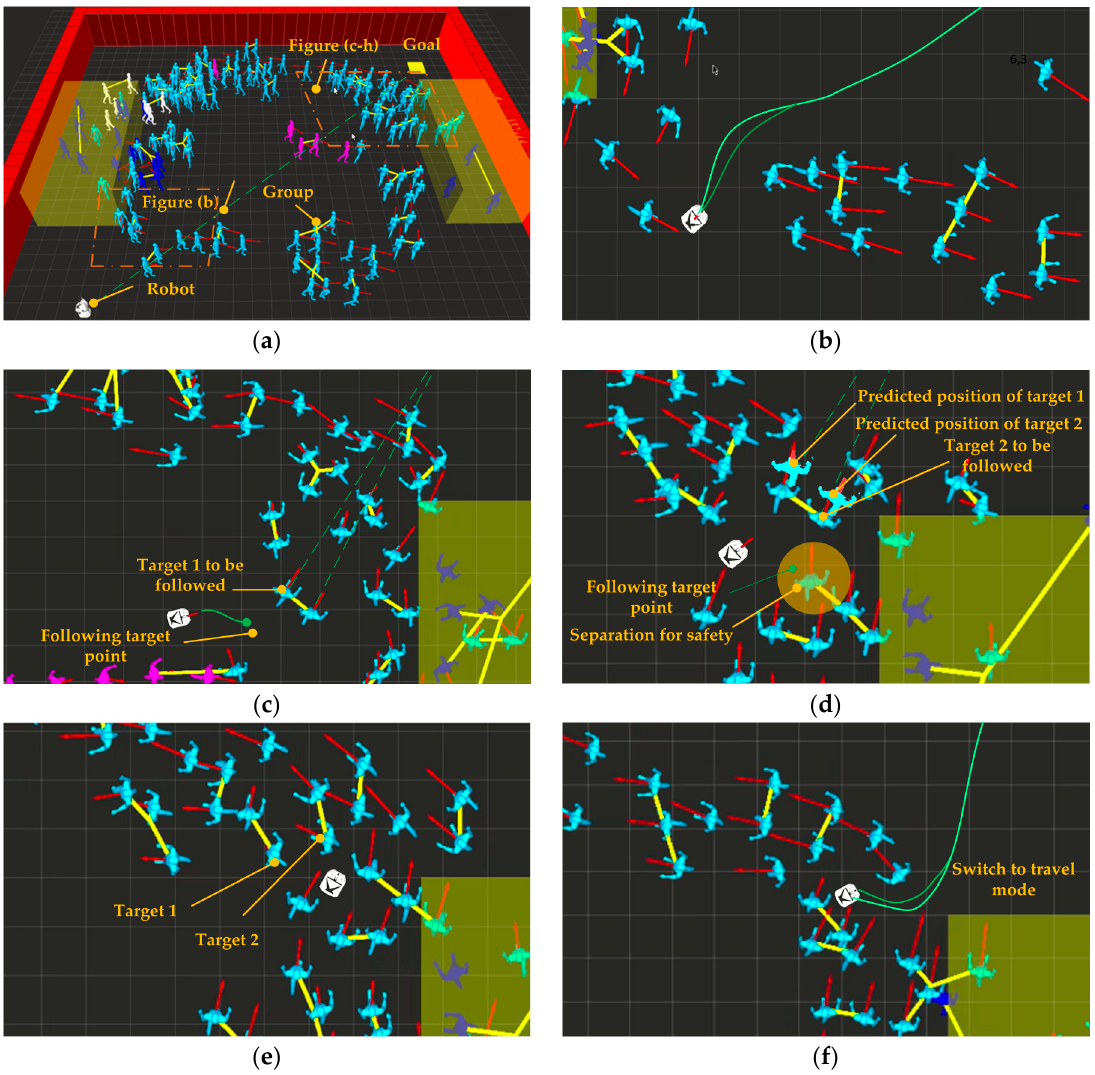
Figure 13. Experiment in a complex crowd simulation environment: ( a ) Overview of the scenario; ( b ) the robot passes through the crowd for the first time; ( c ) the robot chooses to follow the target 1; ( d ) the robot is detecting the accessibility of the candidate following target 2; ( e ) the robot is in the probing mode; ( f ) the robot switches to the travelable mode.